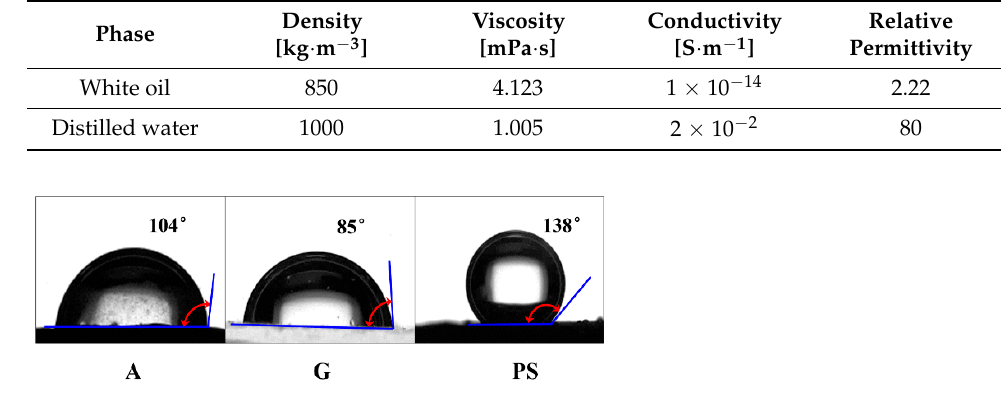
Figure 1. The contact angles of water droplets on the surfaces of glass (G), anthracite (A) and polystyrene (PS) in white oil.